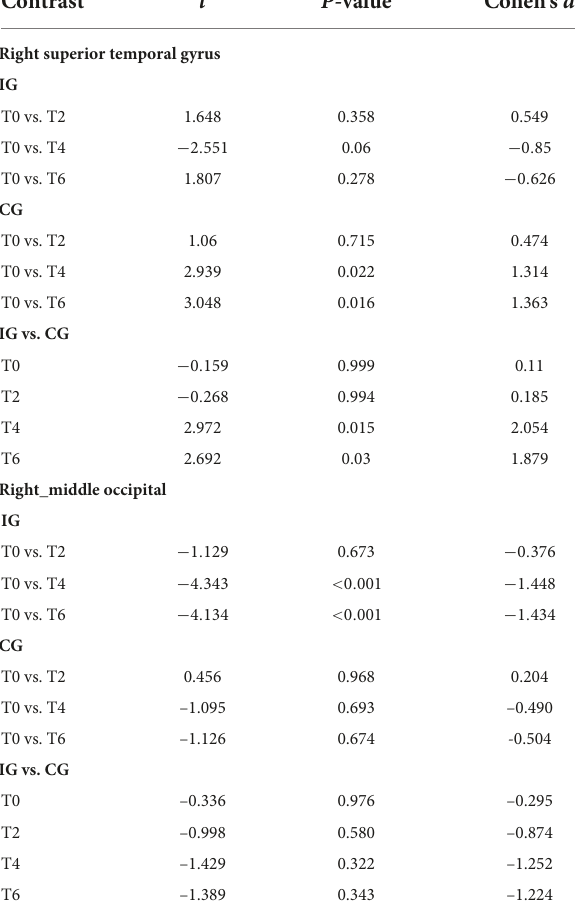
Figure 1 ), and the right ventral striatum ( x , y , z = 12.7, 5.0, 4.2; Supplementary Figure 1 ), including the right lentiform nucleus (cluster size > 42 voxels; Figure 4A ). To assess the the relationship between VO 2max and relative CBF in the IG and CG separately. Therefore, the regression was restricted to those areas showing significance in the above regression analysis (at an inclusive masking threshold of p < 0.01, uncorrected) of both groups pooled. Only the IG showed a significant relation between VO 2max and relative GM CBF located in the right middle occipital region ( x , y , z = 29, − 87.9, 12.3; Supplementary Figure 1 ) and the left middle occipital region ( x , y , z = − 43.3, − 73.9, 14.5; Supplementary Figure 1 ), as well as a trend in the right ventral striatum ( x , y , z = 20.1, − 2.4, − 4.7; r = 0.19; p < 0.005 uncorrected, > 10 voxel; Figure 4B and Supplementary Figure 1